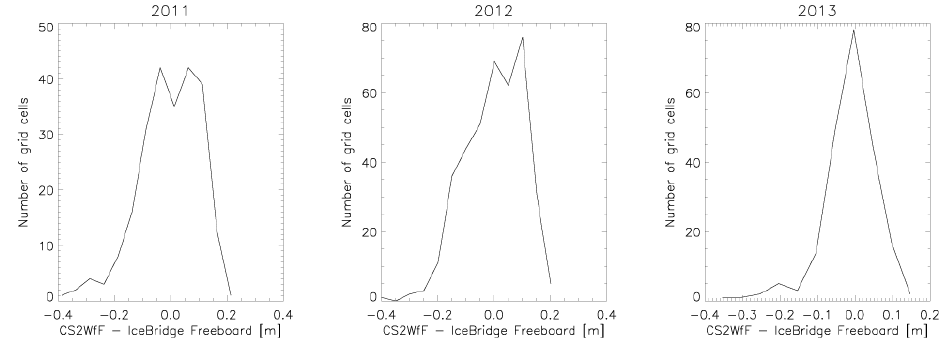
Figure 13. Histograms of the gridded freeboard difference between IceBridge and the CS2WfF method. Table 2. CryoSat-2 freeboard and thickness retrievals from the CS2WfF and ELTF retracking methods compared to IceBridge airborne data. Values pertaining to sea ice thickness are in